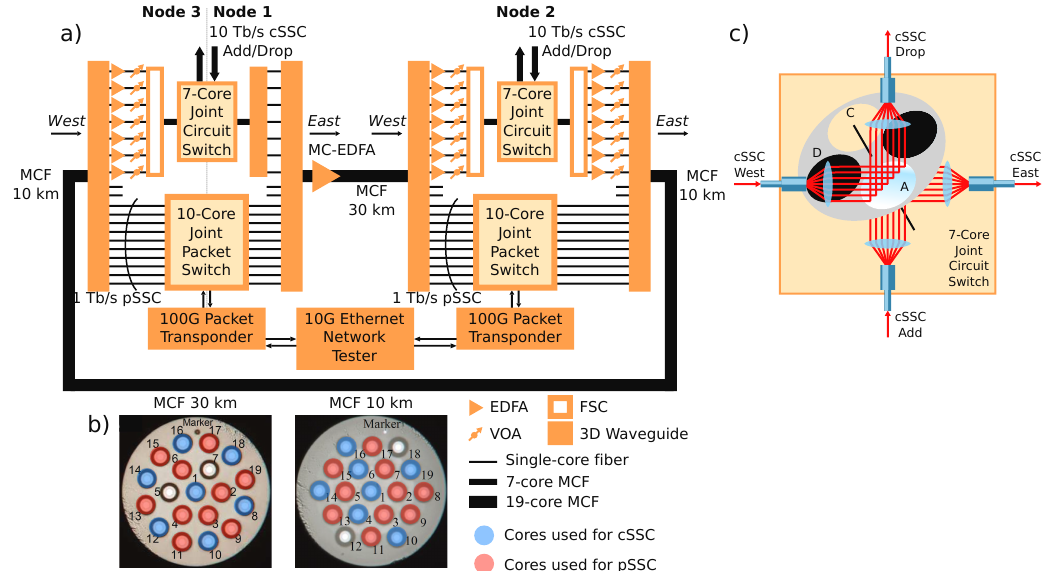
Figure 2. Experimental setup for the spatial division multiplexing (SDM) testbed. ( a ) Simplified structure of the SDM reconfigurable optical add and drop multiplexers (ROADMs). ( b ) Profiles of the 30 km and 10 km 19-core multi-core fibers (MCFs). ( c ) Structure of the seven-core joint circuit switch.